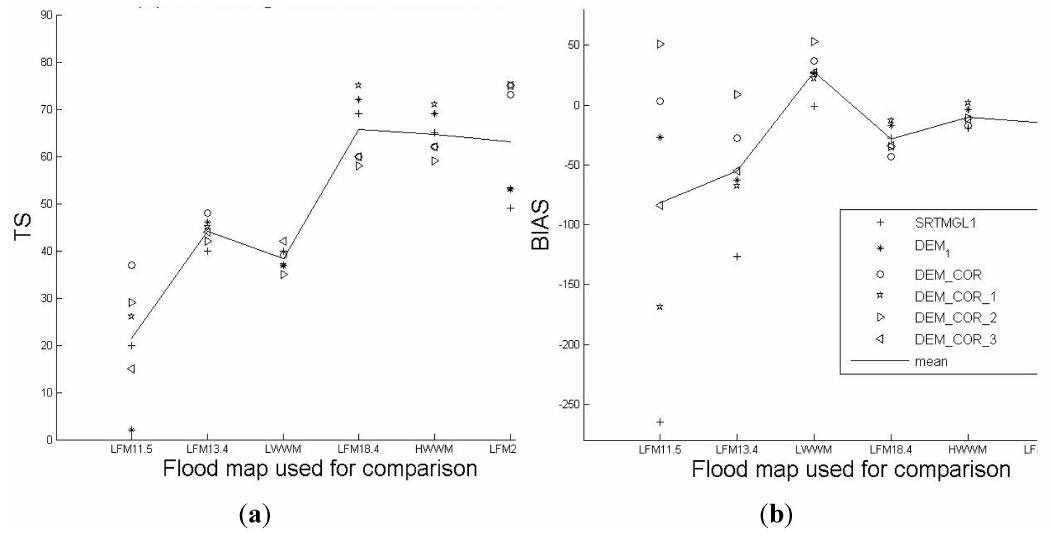
Figure 7. Graph of the indexes of the flooding extent validation. ( a ) TS along different validations, ( b ) BIAS along different validatios.